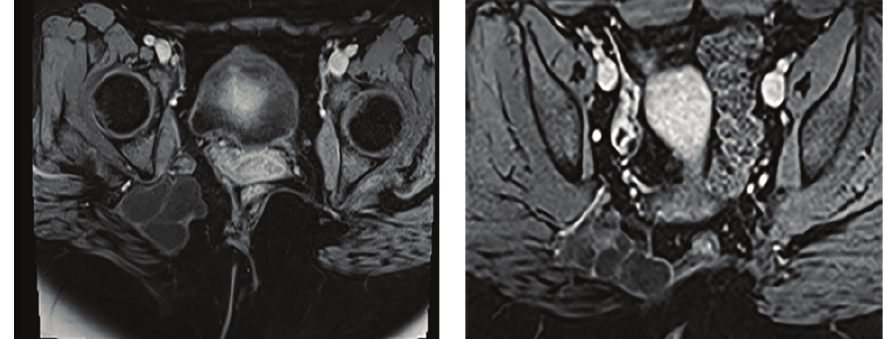
Figure 2: MRI pelvis with recurrent teratoma extending from the retrorectal space and precoccygeal area across midline to the region of right piriformis and deep to right gluteus muscles.